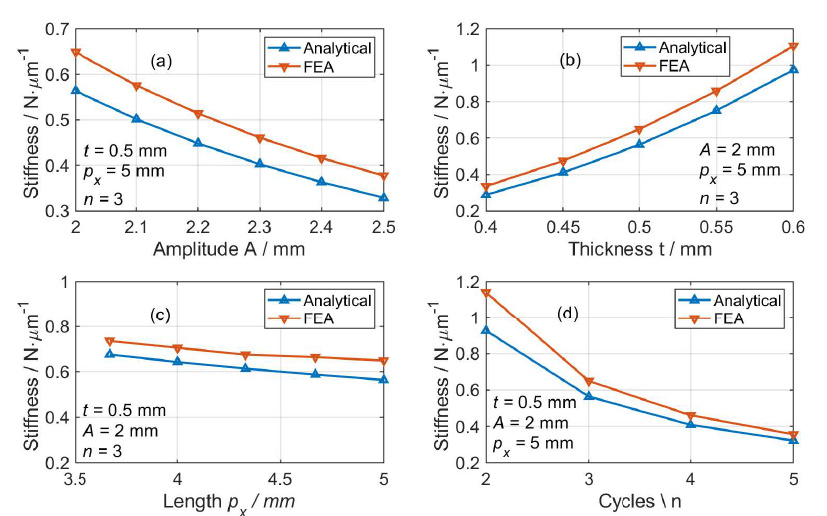
Figure 5. The stage’s stiffness related to ( a ) amplitude A , ( b ) thickness t , ( c ) length p x , and ( d ) cycle number n